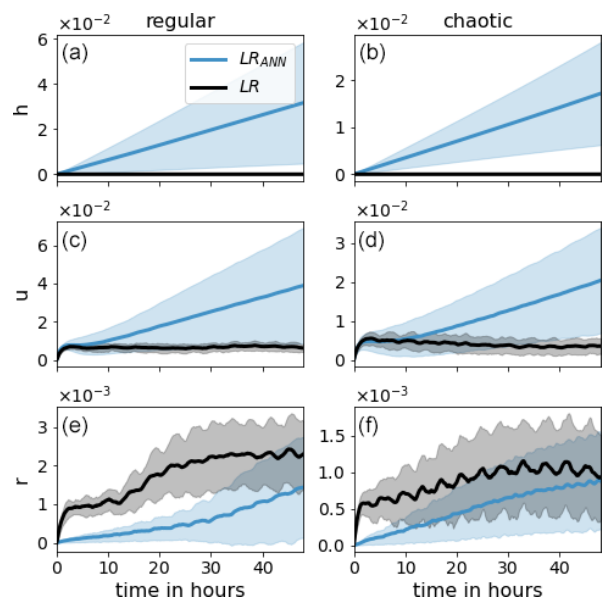
Figure 5. The RMSE evolution of 48h forecasts for model variables h , u , and r (from top to bottom) of LR (black) and LR ANN (blue). The shaded region corresponds to SD total .